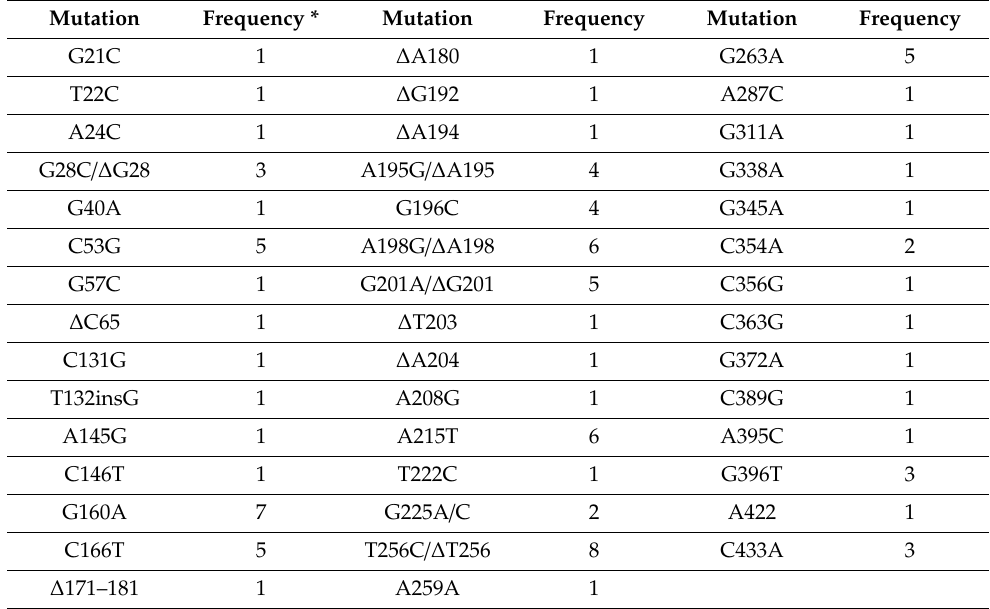
Table 10. Frequency of mutations in the noncoding control region of HPyV10.